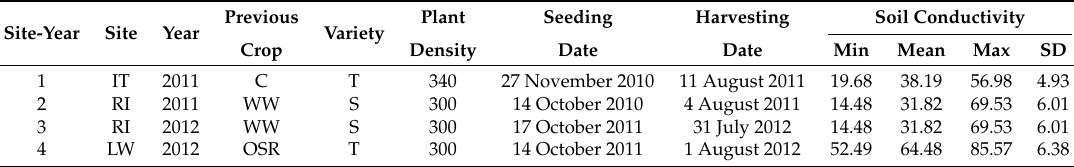
Table 1. Site characteristics for winter wheat ( Triticum aestivum L.): plant density (No. and harvest dates, and electrical soil conductivity (mS), of the three research fields Inneres Täle (IT), Riech (RI) and Lammwirt (LW) at experimental site Ihinger Hof, Renningen (Germany). C = Corn, WW = Winter wheat, OSR = Oilseed rape, T = Toras, S = Schamane, SD = Standard deviation. Previous Plant Seeding Site-Year Site Year Variety Density